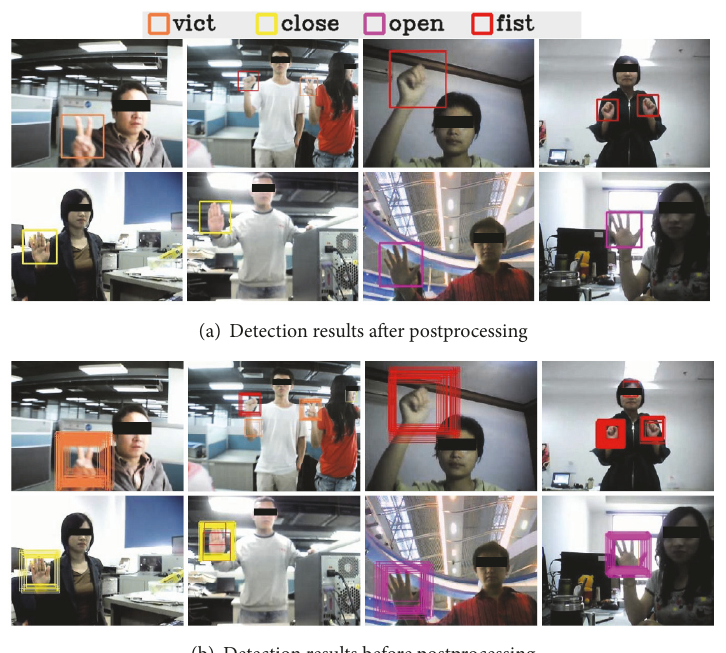
Figure 6: Detection results based upon the proposed softmax-based cascade detector. Different predictions are marked with rectangles of different